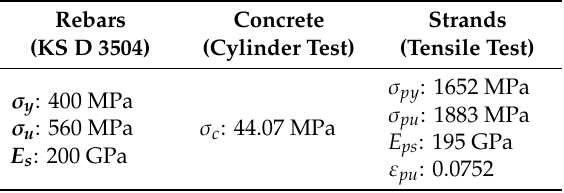
Table 2. Mechanical properties of materials.